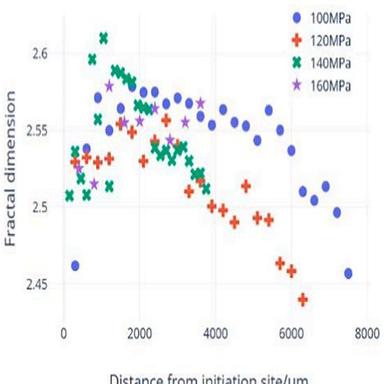
Variations of fractal dimensions.